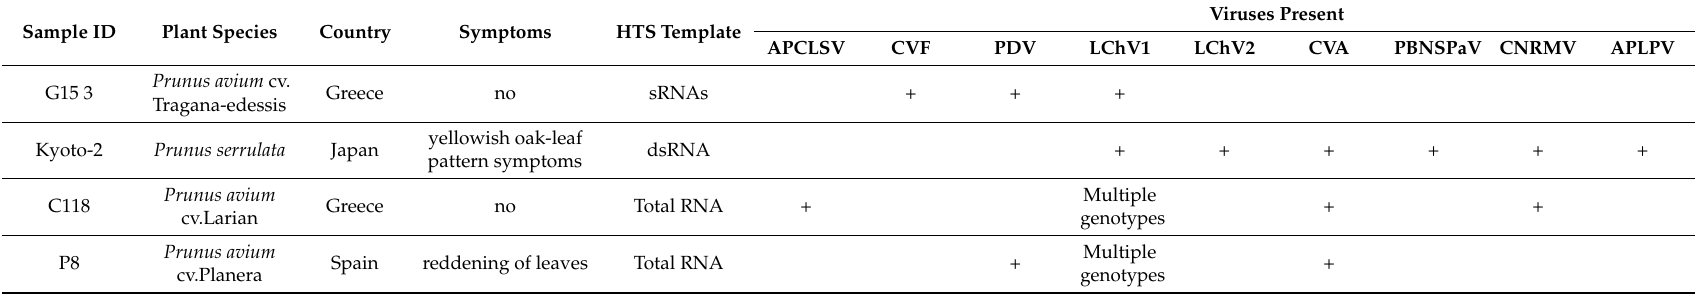
Table 1. Description of analyzed samples and viral species identified with high throughput sequencing